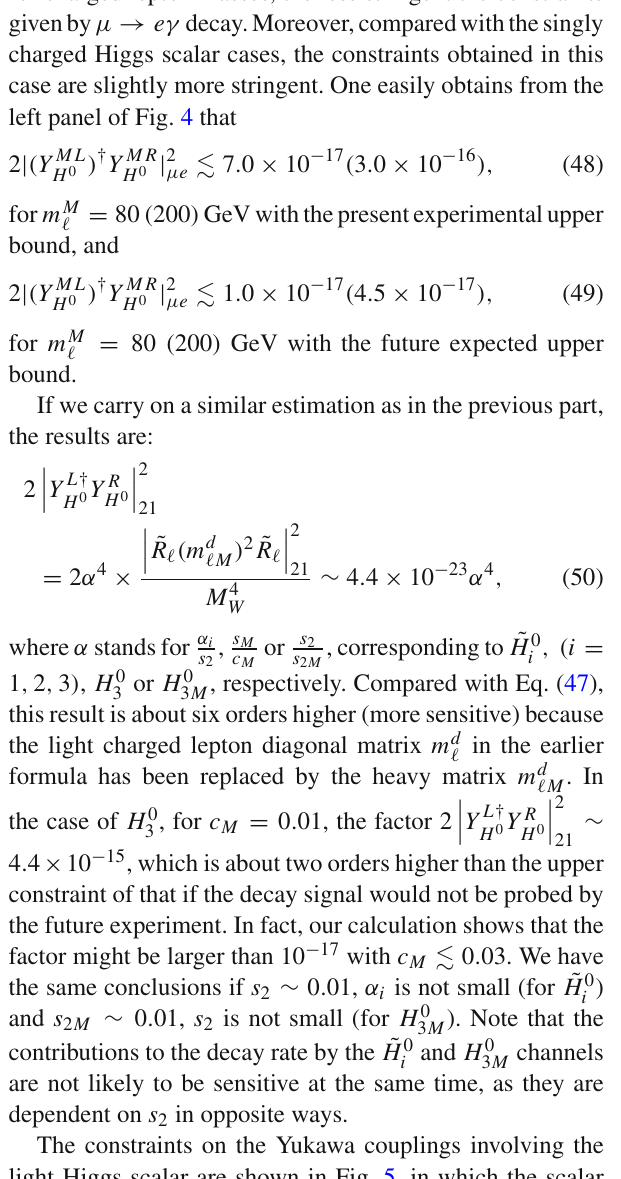
Fig. 5 The dependence of 2 | ( Y L φ (future expected) sensitivities, corresponding to blue (red) lines, on (i) light neutral Higgs scalar mass (upper panel) for m M (cid:4) = 80 ( 200 ) GeV, solid (dashed) lines; (ii) mirror charged lepton masses (lower panel) for = 10 − 3 ( 50 ) GeV, solid (dashed) lines m φ 0 s